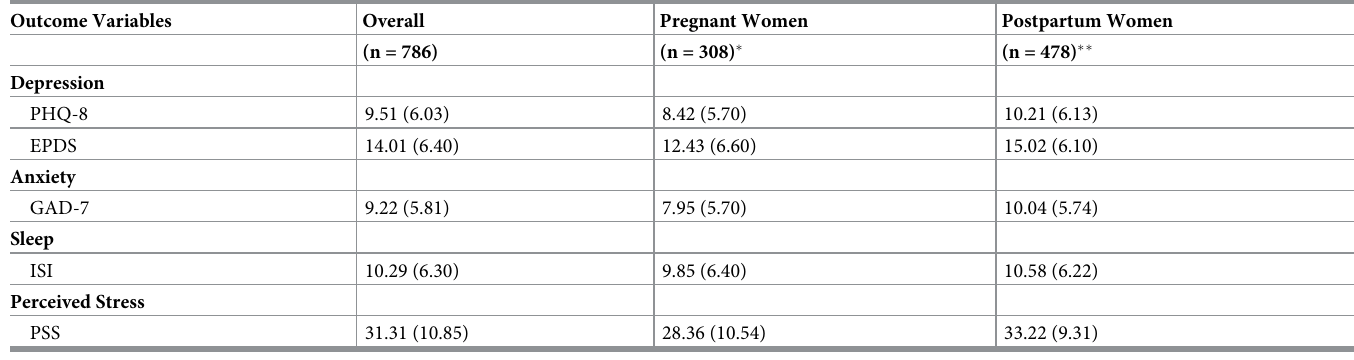
Table 2. Mental health outcomes (sample overall, and by pregnancy